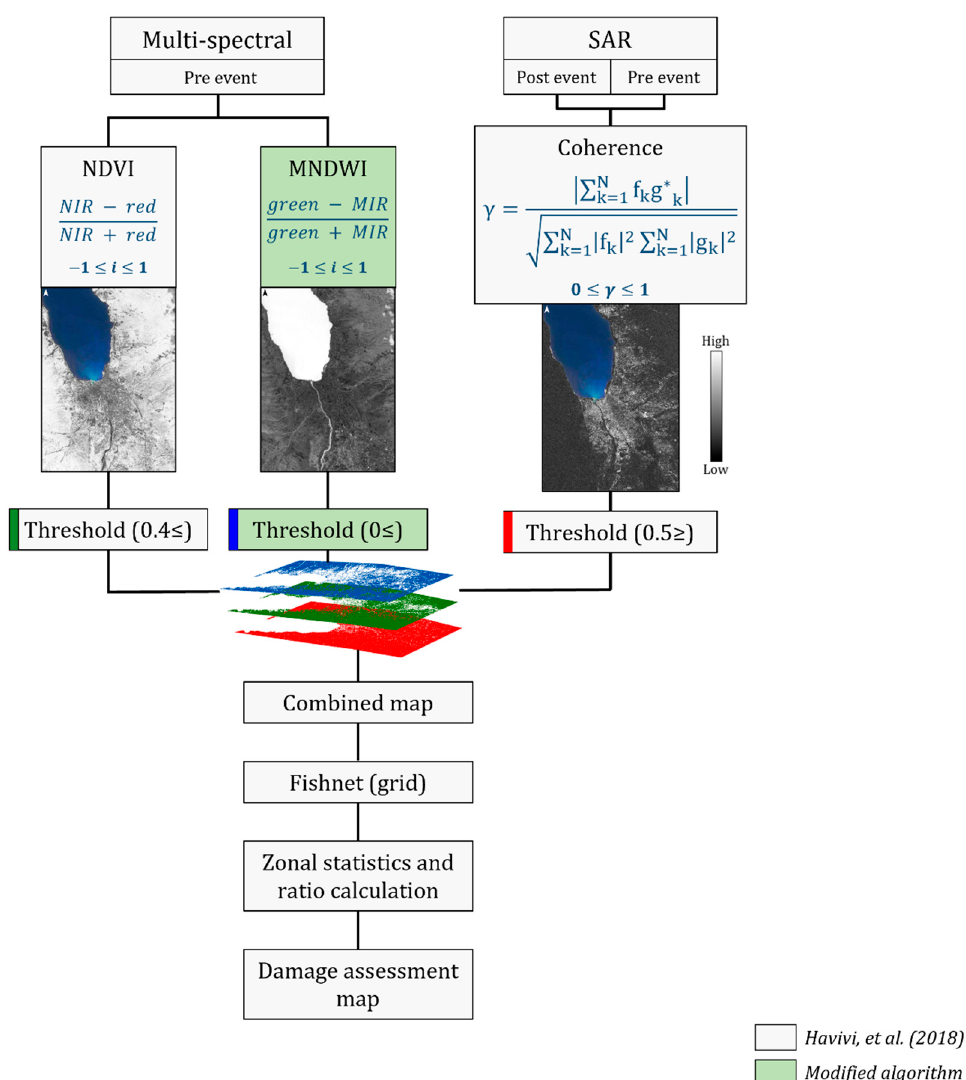
Figure 1. Algorithm outline. Grey blocks represent the original algorithm, proposed by ref. [1]. Green blocks represent the steps inserted to the modified process. The coherence ( γ ) is calculated by complex SAR images: f k and g k ; f k g* k is the expectation value operator. N represents the estimation window size in the azimuth and range directions. Light shades in the maps represent high values, and dark shades represent low values. Light shades in NDVI and MNDWI represent vegetation areas and water bodies, respectively. Light shades in the coherence map represent stable areas, and dark shades represent changed areas.